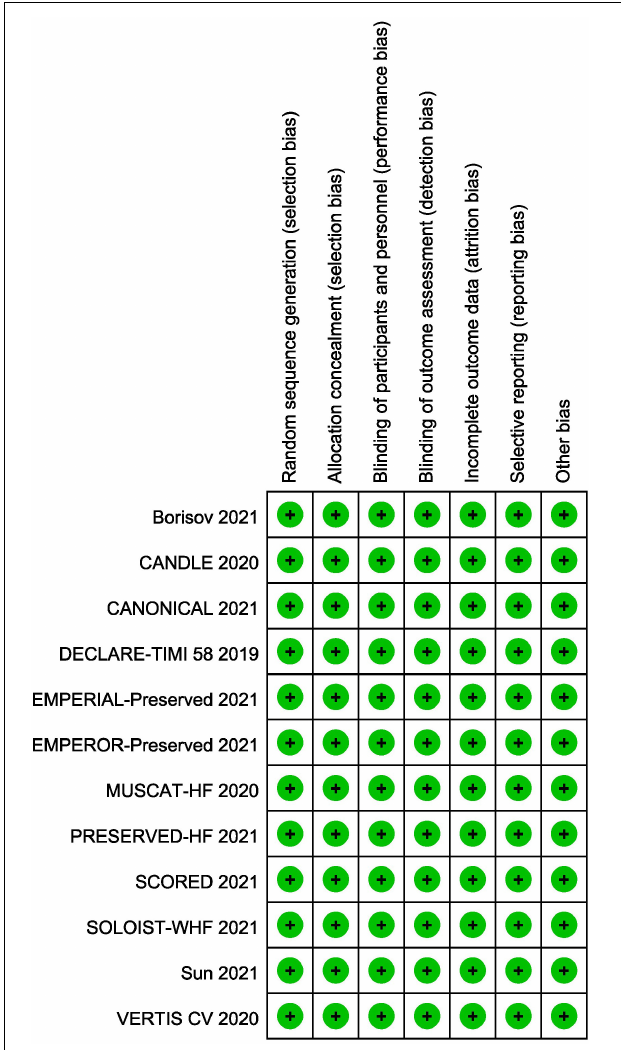
FIGURE 2 | Risk of bias